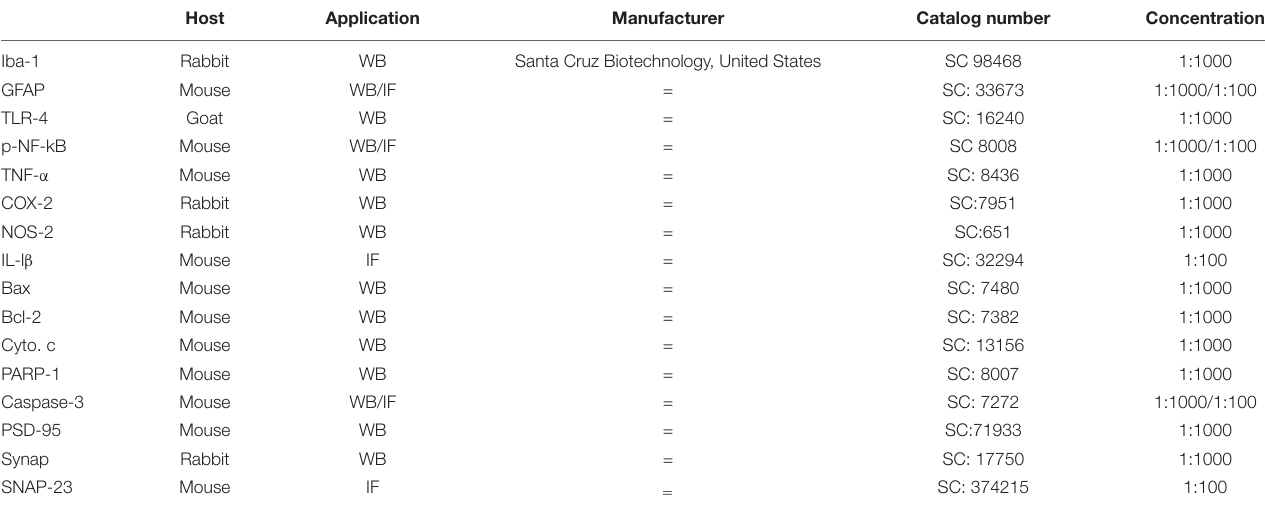
TABLE 1 | Primary antibodies